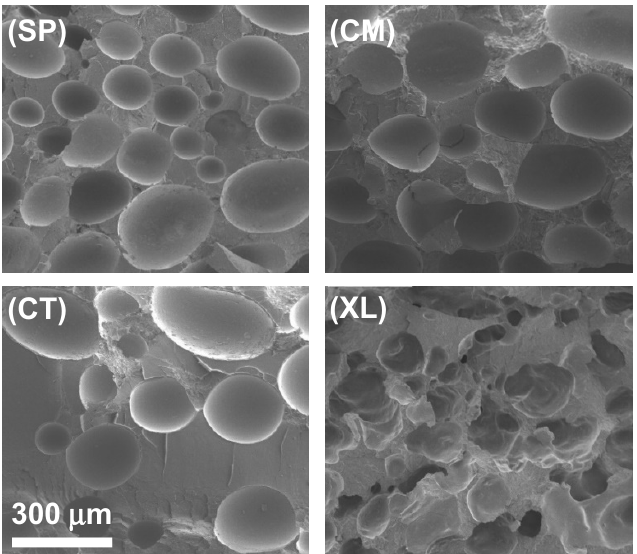
Figure 3. SEM images of SSSP-processed (SP), cryomilled (CM), manually blended control (CT), and crosslinked/cryomilled (XL) PLA foams with 6.5 wt% CFA.